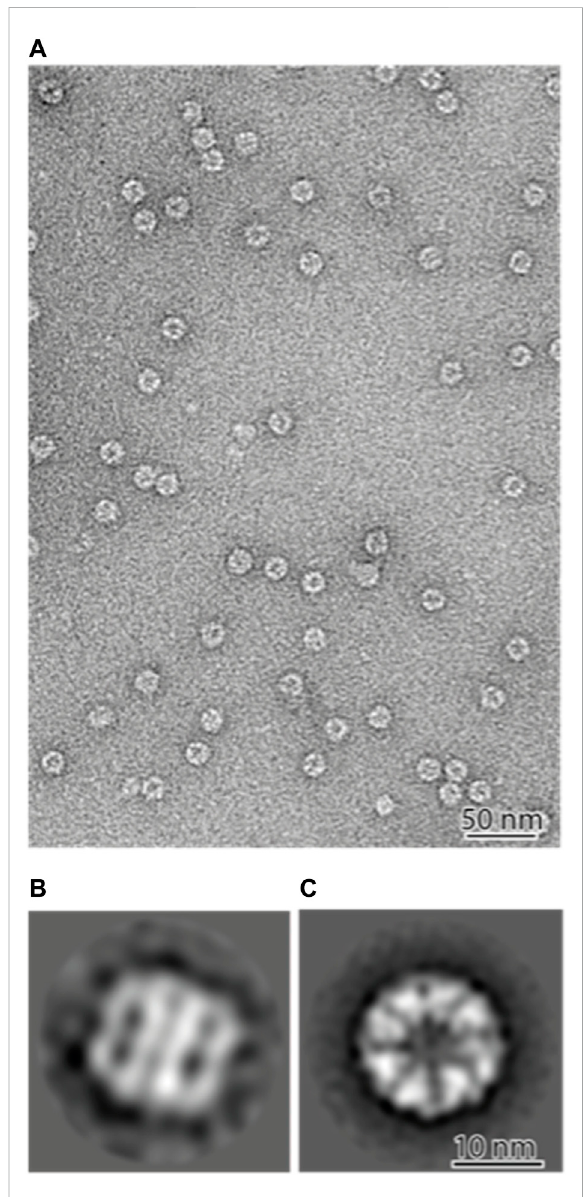
FIGURE 4 Negative stain electron microscopy of the PfCCT complex (A) ×100000 nominal magni fi cation. The majority of the complexesare vertical on thegridand thereforeshow “ top-down ” views. (B,C) 2D classi fi cations of 9025 particles shows the majority of the particles are top-down views (C) with a minority of side views (B) . The PfCCT complex measures 170 Å in diameter and 180 Å in height, with each subunit around 60 Å in